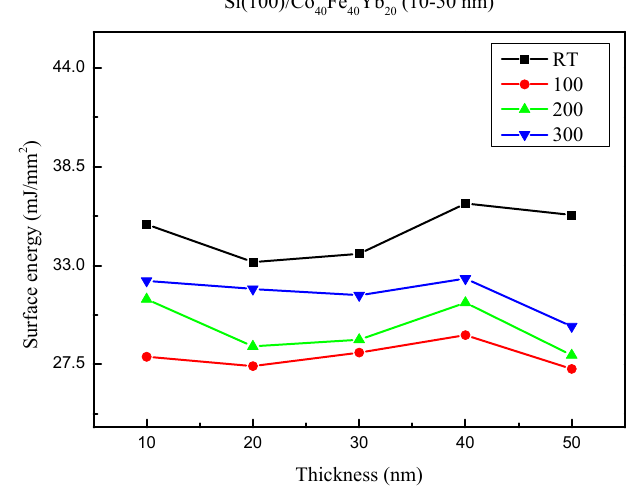
Figure 5. Surface energy of Co 40 Fe 40 Yb 20 thin films.